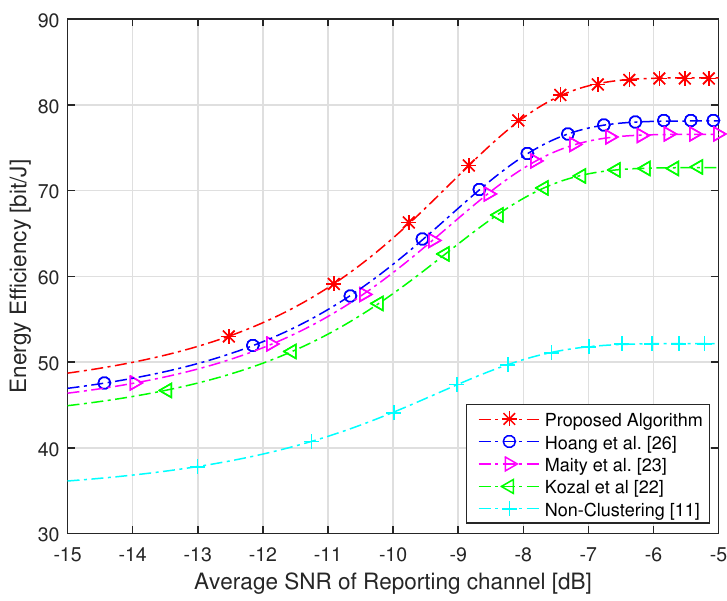
Figure 7. Energy efficiency with an increasing signal-to-noise ratio (SNR) of the reporting channel.